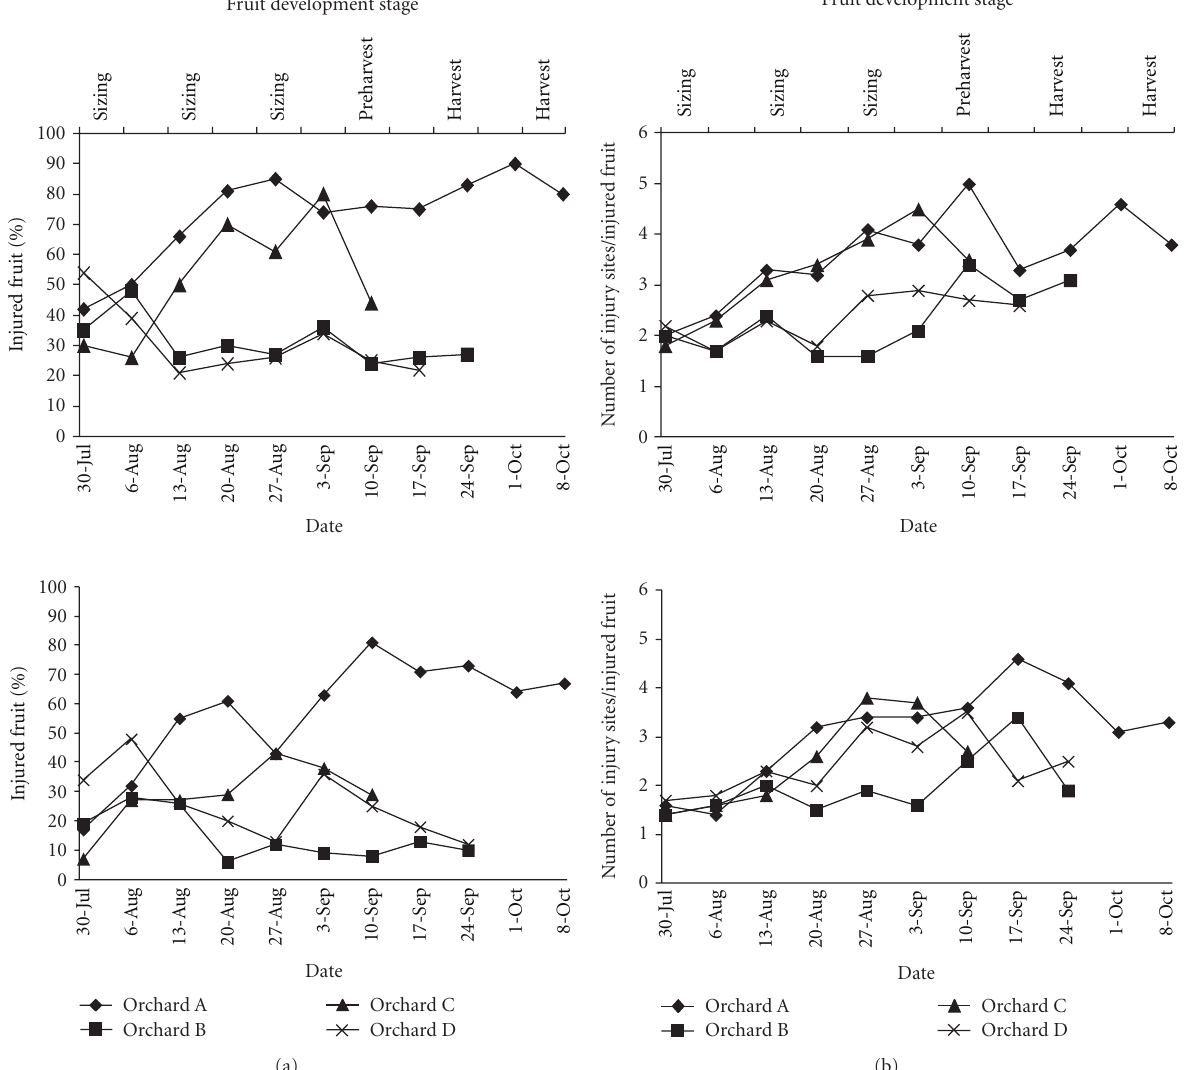
Figure 6: (a) Percent injured apples in 2010 at orchards A–D from the plot exterior (top) and interior (bottom) and (b) the number of injury sites per injured fruit in 2010 at orchards A-D in the plot exterior (top) and interior